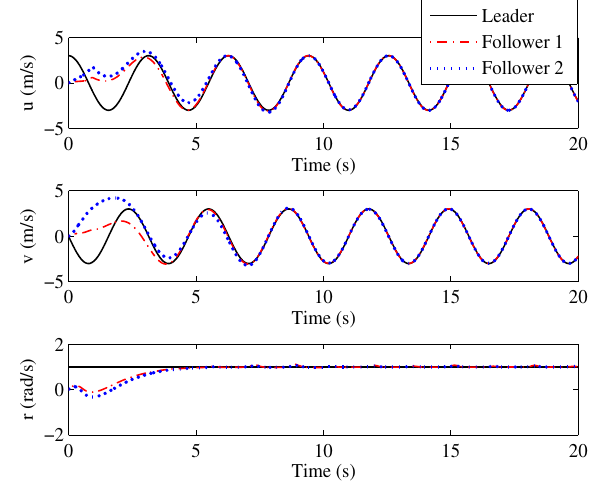
Figure 8. Velocities of the leader and followers.